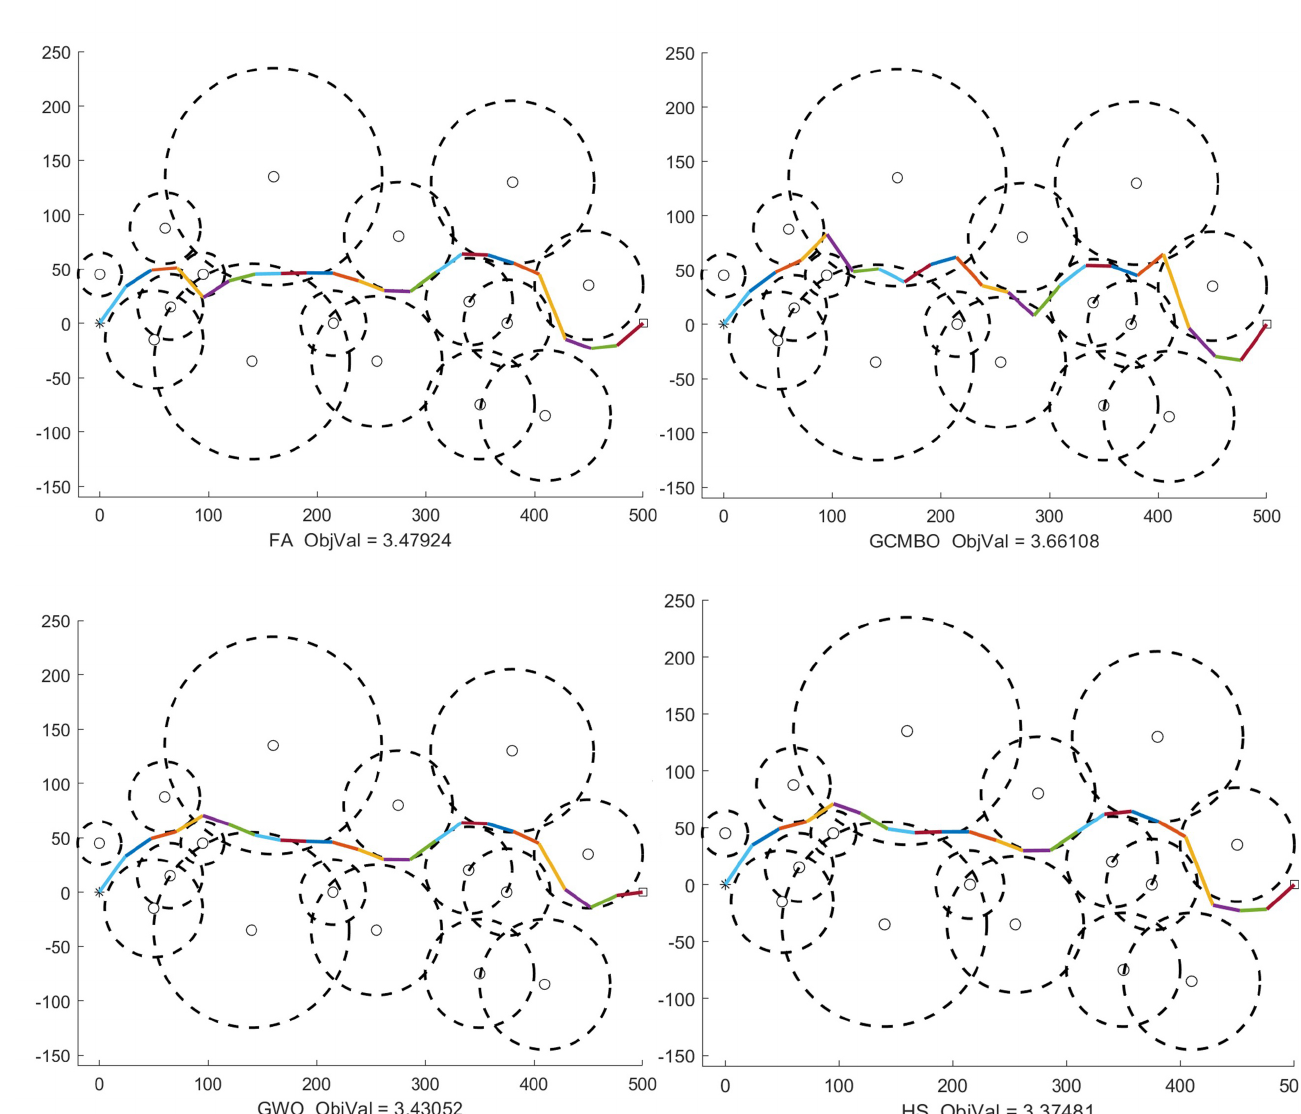
Figure 4. The comparison performance of different swarm intelligence algorithms including firefly algorithm (FA), monarch butterfly optimization with greedy strategy (GCMBO), grey wolf optimization (GWO), harmony search (HS) for Case 8 with D = 20, N =